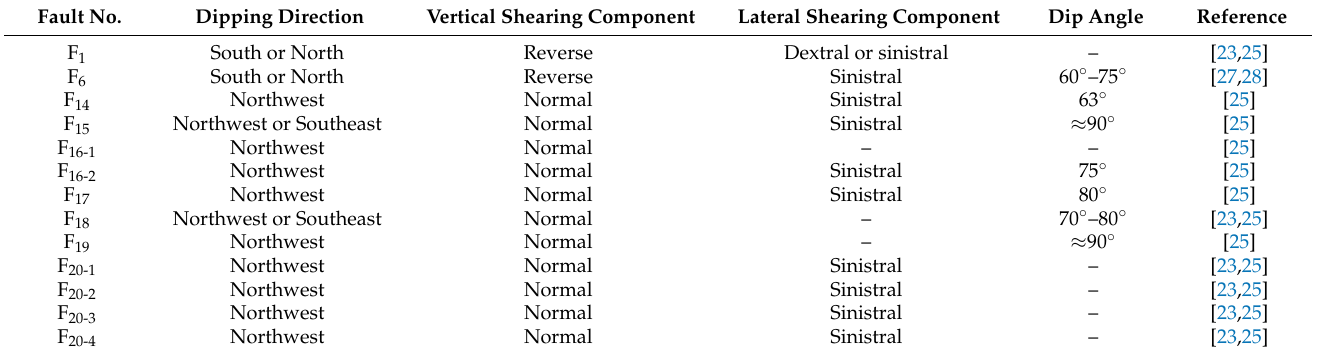
(Table 1). Due to the complex structural geology along the fault zone, the characteristics of these two faults are unclear. Table 1. The characteristics of Jiujing region faults in the